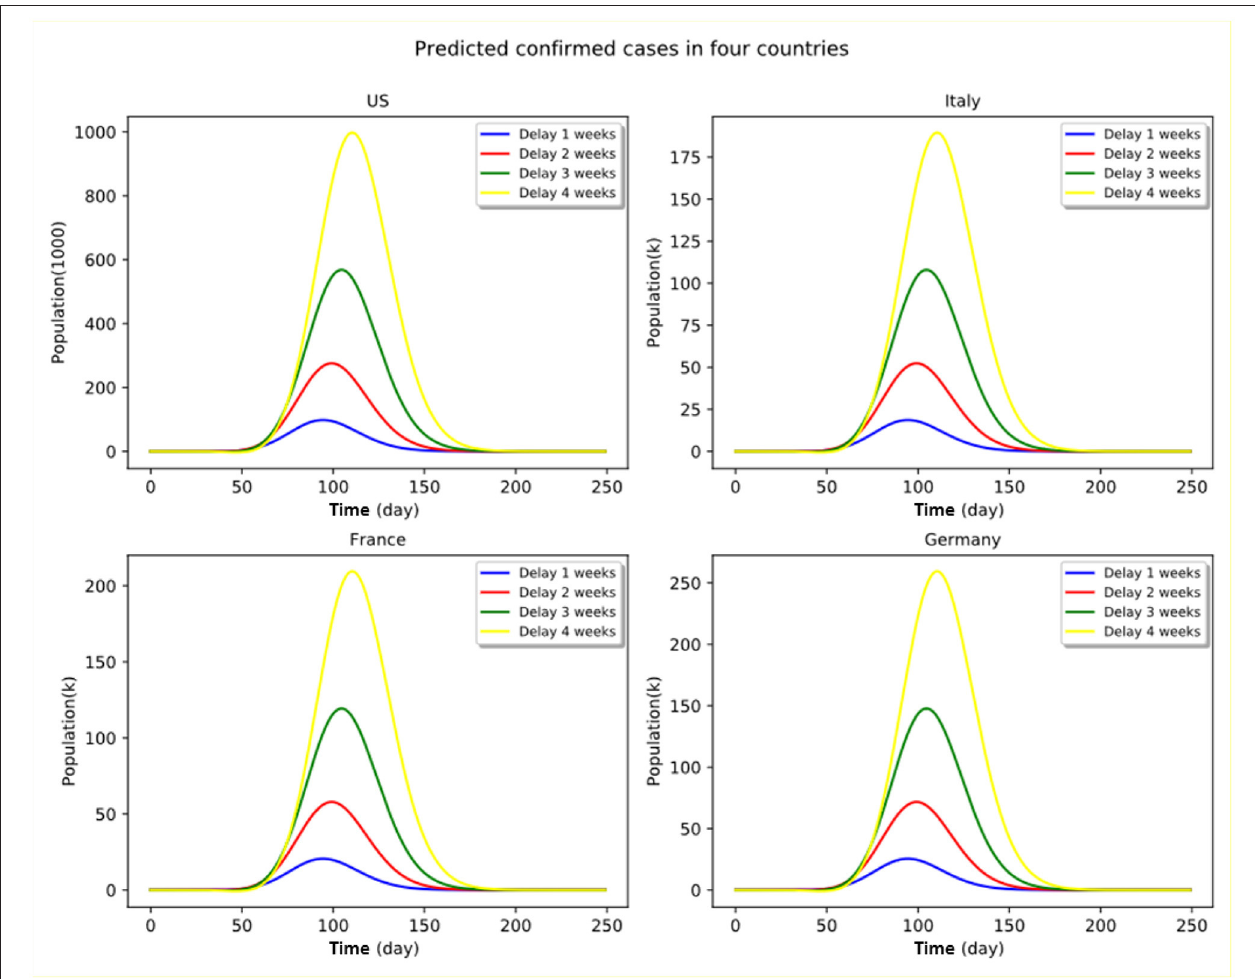
FIGURE 4 | Proactive vs. delayed implementation of P&C measures under stringent policy. Numbers shown in the panel graphs are relative to the no-delay